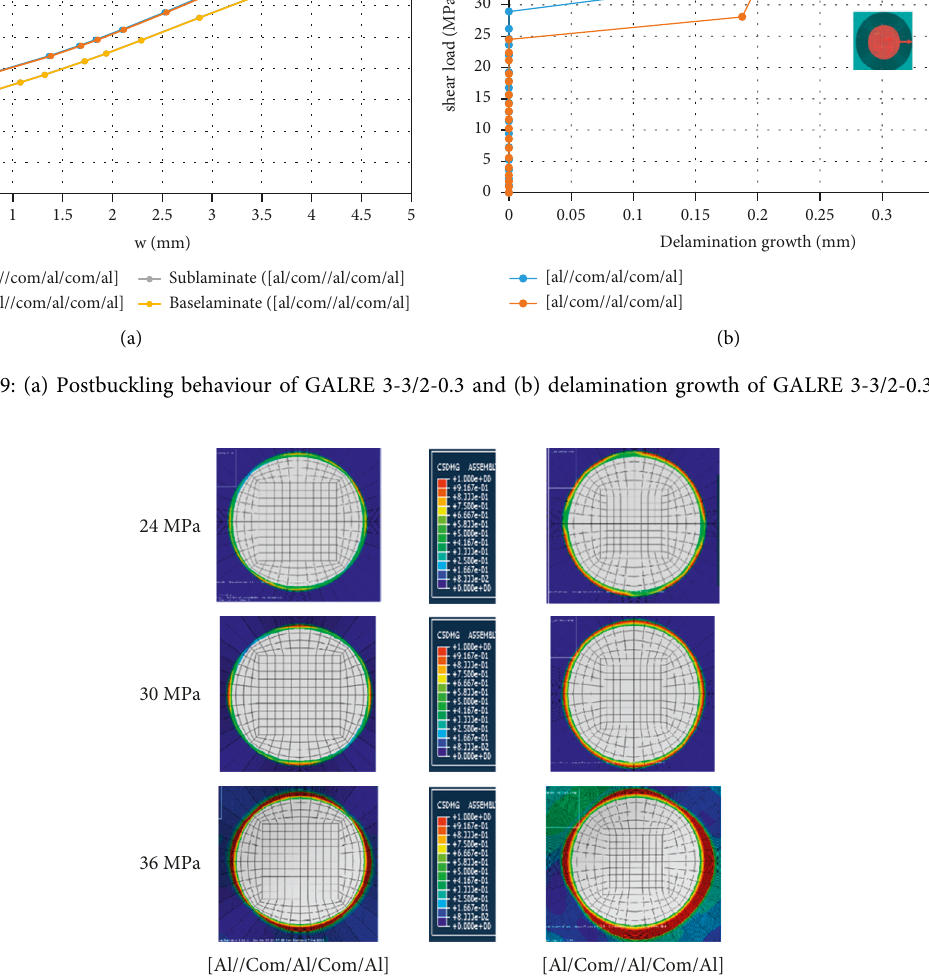
Figure 10: Contour plots of delamination growth of GLARE 3-3/2-0.3 in different shear load conditions.